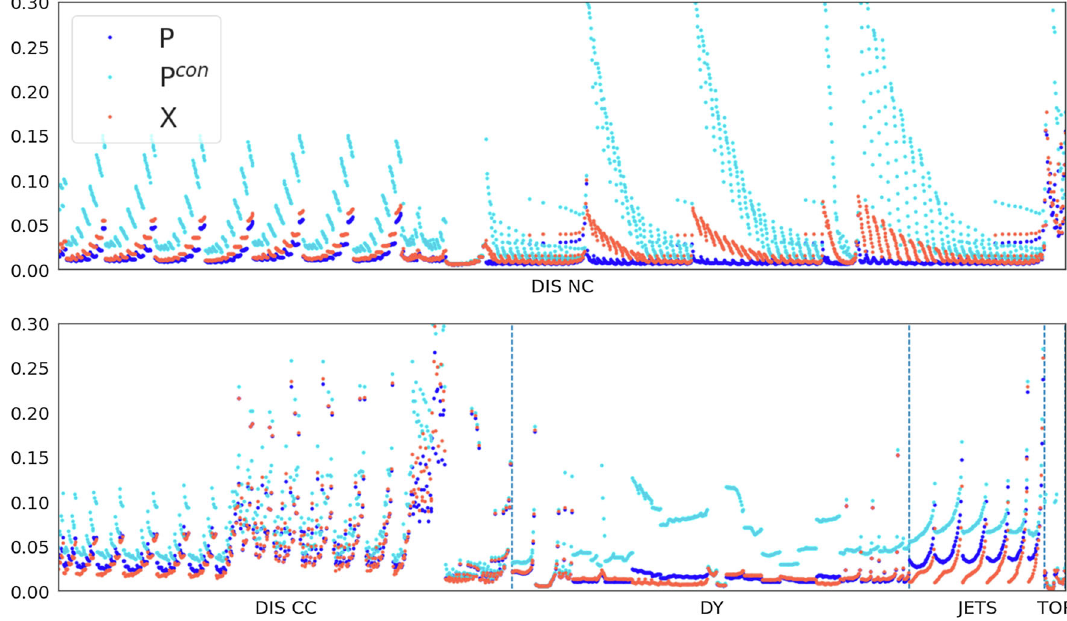
√ P ii Eq. (4.33) (blue) compared to the PDF uncertainty